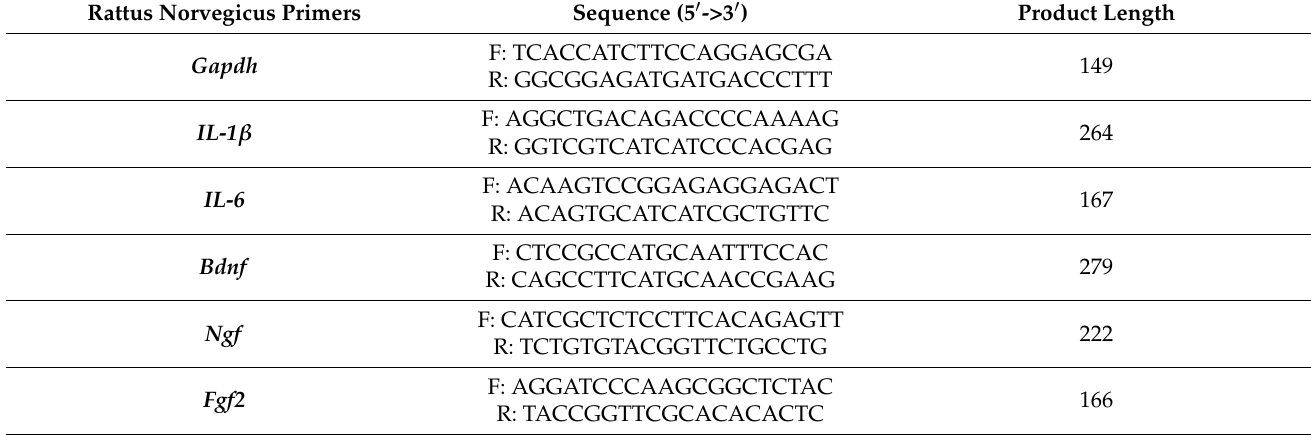
Table 3. List of primers used with qRT-PCR in the study. Brain-derived neurotrophic factor: Bdnf ; Glyceraldehyde-3-Phosphate Dehydrogenase: Gapdh ; Nerve growth factor: Ngf ; Fibroblast growth factor 2: Fgf2